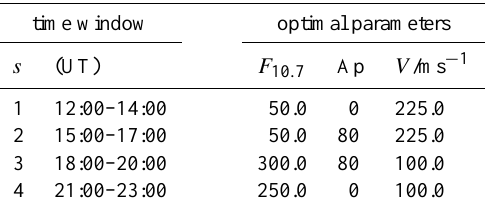
Table 1. Key driver variables for SAMI2 optimised against the en- semble mean from MIDAS, along the latitudinal line segment, for the VTEC feature space, and for different time windows during 20 November 2003.